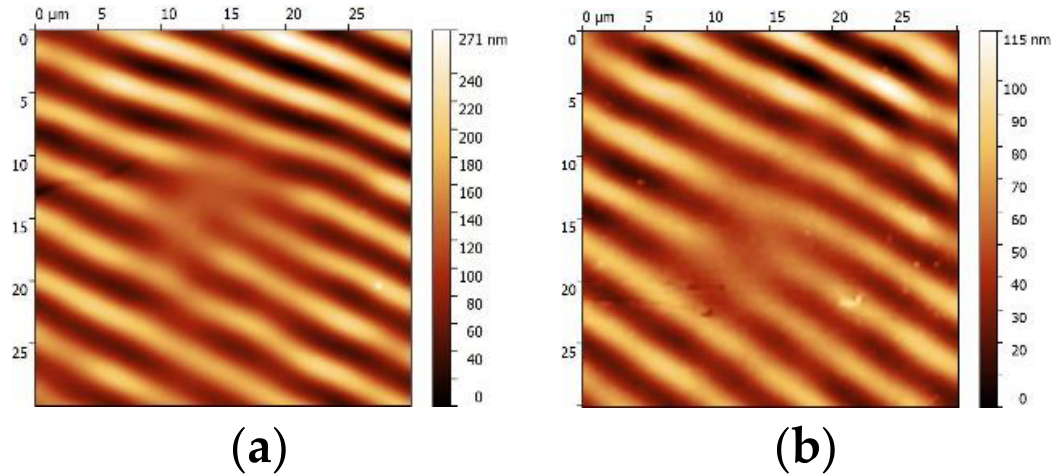
Figure 6. SPM images of the produced structure upon interference of beams with the same polarization: ( a ) linear polarization at incidence angles of +45 ◦ and − 45 ◦ ; ( b ) circular right- and left-hand polarizations.